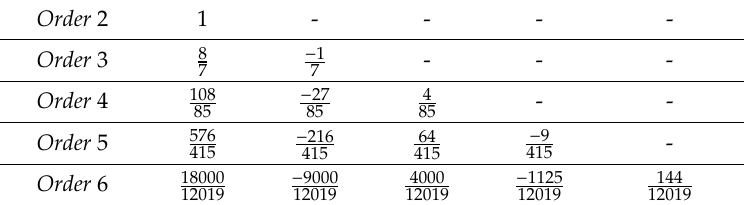
Table 2. Coe ffi cients for “short” ESIMM methods of order 3-6 Order 2 1 - - -